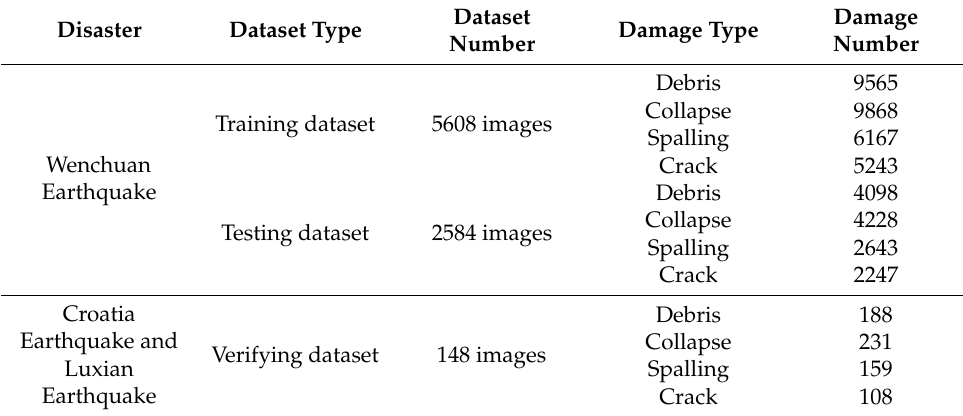
Figure 3. Visualization of our GDBDA dataset. The rectangles represent damaged bounding boxes. Overall, 856 images with 3968 × 2976 pixels from smartphones and cameras were annotated for damage recognition, and 3918 cropped damage images with 800 × 800 pixels were marked. Data augmentation helped to expose the network to more diverse data, leading to a more generalizable output. Considering the image size and damage characteristics, the selected enhancement methods included image rotation, image flipping, color transformation, and image stretching. Then, a total of 8192 sample images were obtained, and 44,059 damage regions were marked. The dataset pertaining to the Wenchuan earthquake was subdivided into two groups: a training set for training the model, which accounted for 70% of the data, and a test set for evaluating the model, which accounted for the remaining 30%, as shown in Table 1. Since the number of damaged parts in different images varied from each other, the specific sample for training and testing was manually filtered. Table 1. Dataset information of different damage types in GDBDA.